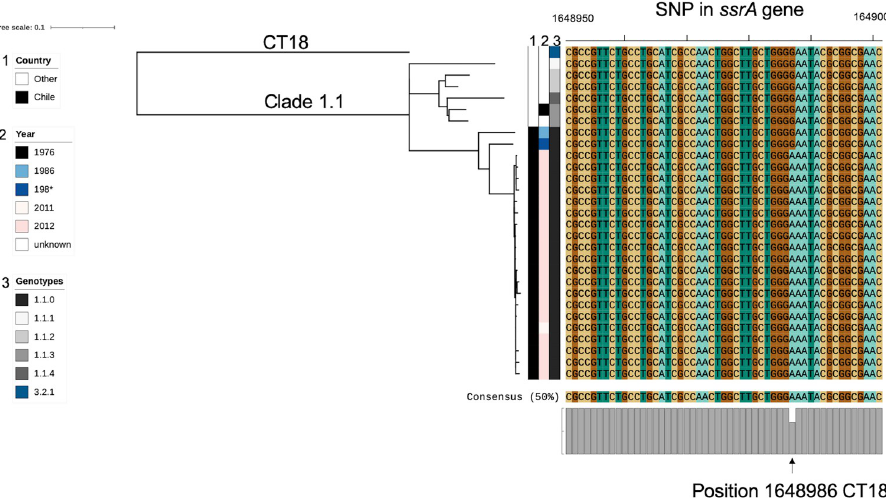
Fig 3. S . Typhi clade 1.1 phylogeny showing sequences carrying ssrA mutation ( ssrA- G639E). Phylogenetic core genome analysis of all S . Typhi isolates of genotype 1.1 identified from the global collection. The majority of these isolates were collected in Santiago (black bar); two isolates belonged to the 1980s collection appearing ancestral to the 2010s collection. The twenty isolates from 2011–2012 showed an interesting cluster with a median SNP distance of 8 SNPs which is unlikely to have evolved among acute cases, where the mutation rate is calculated to be < 1 SNP/ genome/year, in one year. Also shown is an alignment of a section of the ssrA gene, showing the conserved SNP at position 1648986 of the S . Typhi CT18 reference genome. � the precise isolation year of one of the 1980s isolates was unclear.